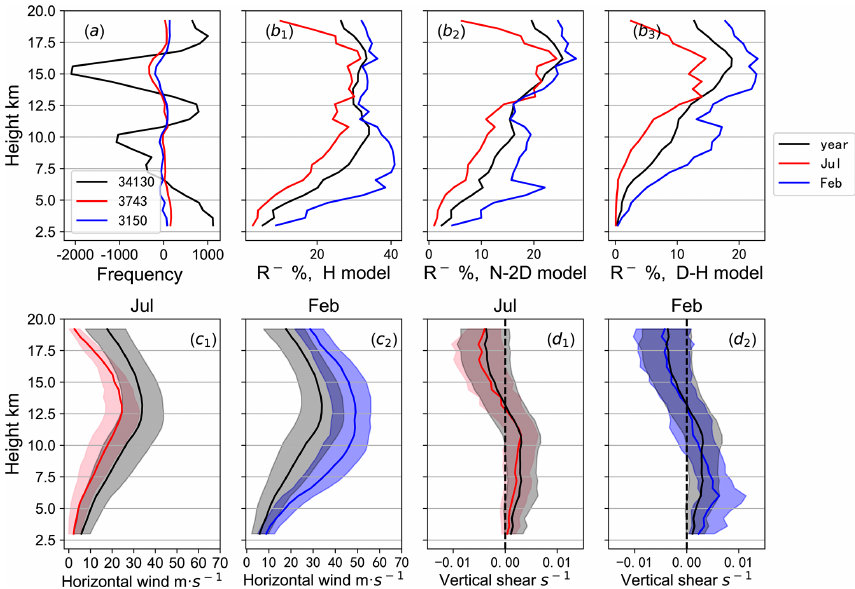
Figure 4. (a) Deviation profile of the data volume involved in the statistics and the mean value of the profile. The annual mean value is 34130, the mean value in July is 3743 and the mean value in February is 3150. (b.1–b.3) Probability of N-TKE in each gate for the H model, N-2D model and D–H model, respectively. Panels (c.1) , (c.2) and (d.1) , (d.2) are the median, upper and lower quartile profiles of horizontal wind speed and the vertical shear of horizontal wind speed, respectively. Black, red and blue represent the characteristics of the year, July and February, respectively. A total of 3 years of radar observational data from 2012 to 2014 were used in the statistics.